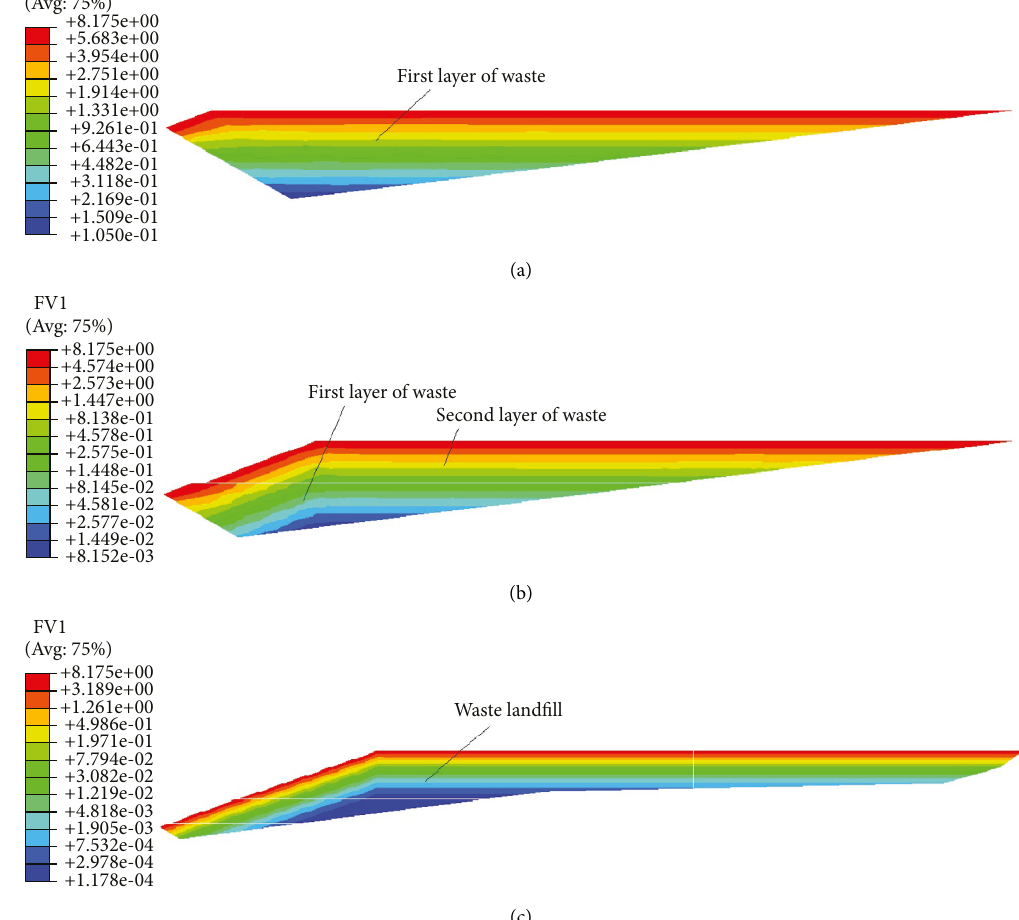
Figure 4: Simulated cloud chart of waste saturation permeability (completed 1st ∼ 9th layer of waste). (a) Simulated cloud chart of waste saturation permeability when the 1st layer of waste is completed (m/day). (b) Simulated cloud chart of waste saturation permeability when the 2nd layer of waste is completed (m/day). (c) Simulated cloud chart of waste saturation permeability when the 9th layer of waste is completed